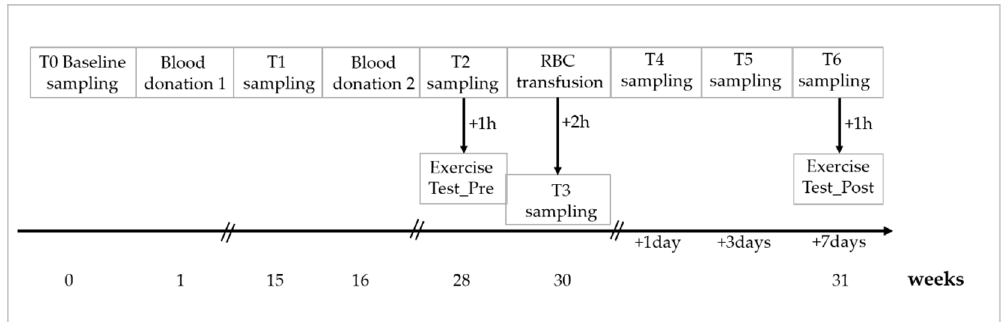
Figure 1. Schematic overview of the study design.